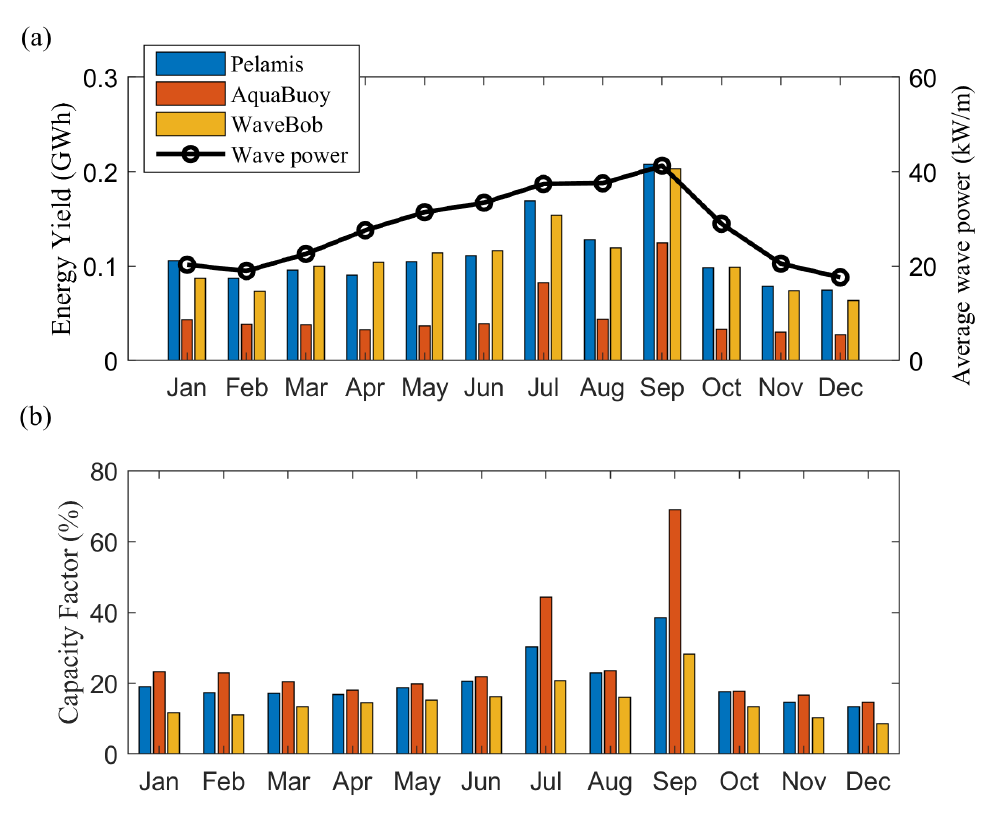
Figure 14. The performance of the three WEC devices at the first site off the coast of Yogyakarta; ( a ) the average monthly energy yield in GWh and ( b ) the WEC capacity